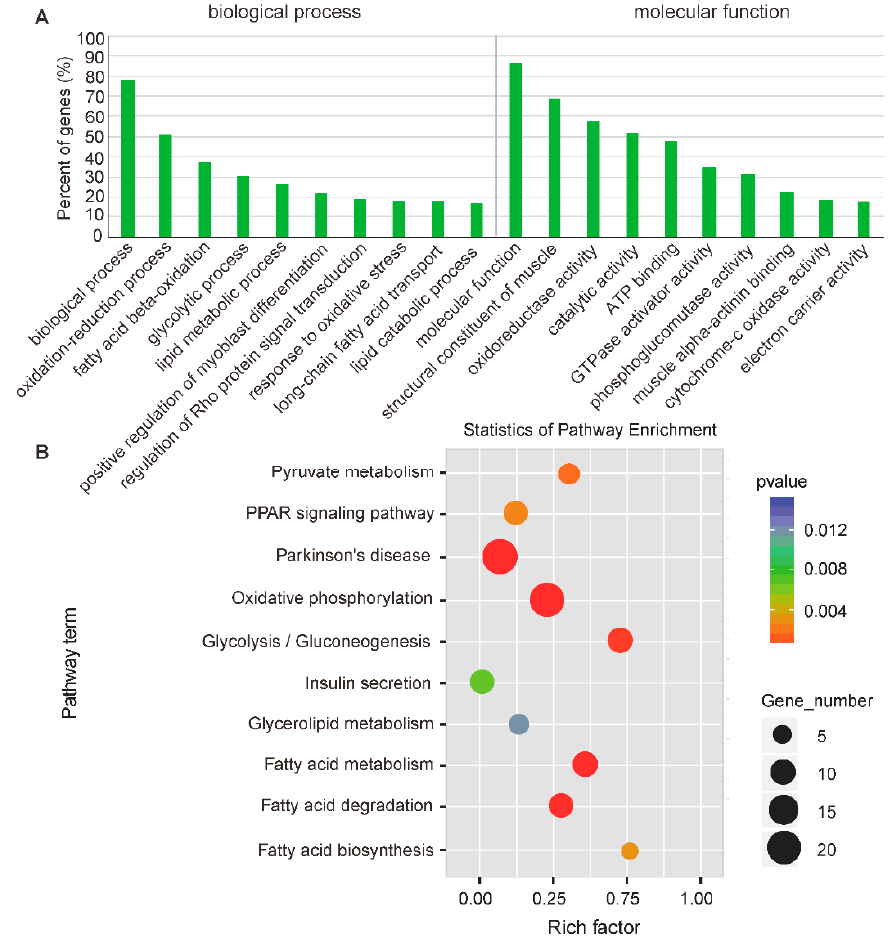
Figure 6. Functional enrichment analysis of di ff erentially expressed cis lncRNA target genes between LDM and PMM. ( A ) Gene Ontology (GO) terms and ( B ) KEGG pathways enriched for neighboring target genes of DE lncRNAs ( cis -regulation). Benjamin-corrected modified Fisher’s exact test was used to calculate the p